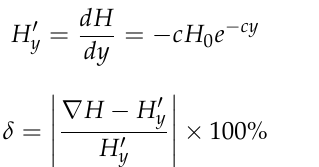
Table 1. Values of parameters for modeling calculation.